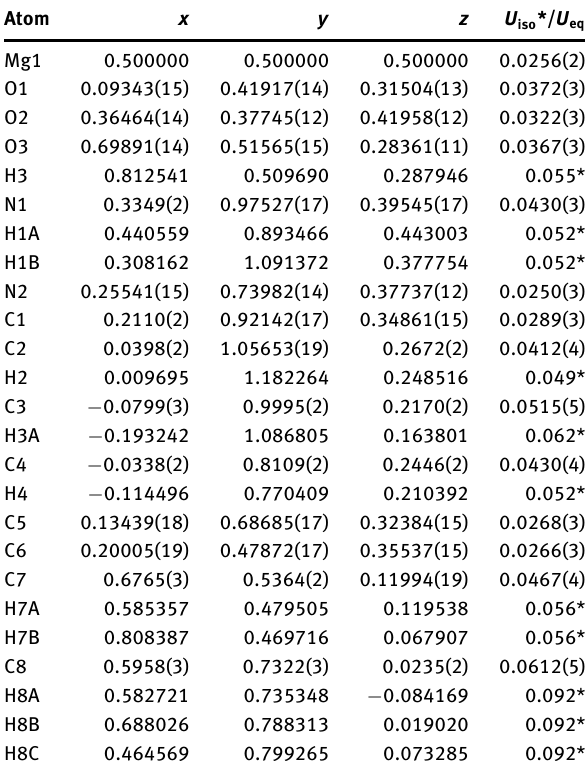
Table 2: Fractional atomic coordinates and isotropic or equivalent isotropic displacement parameters (Å 2